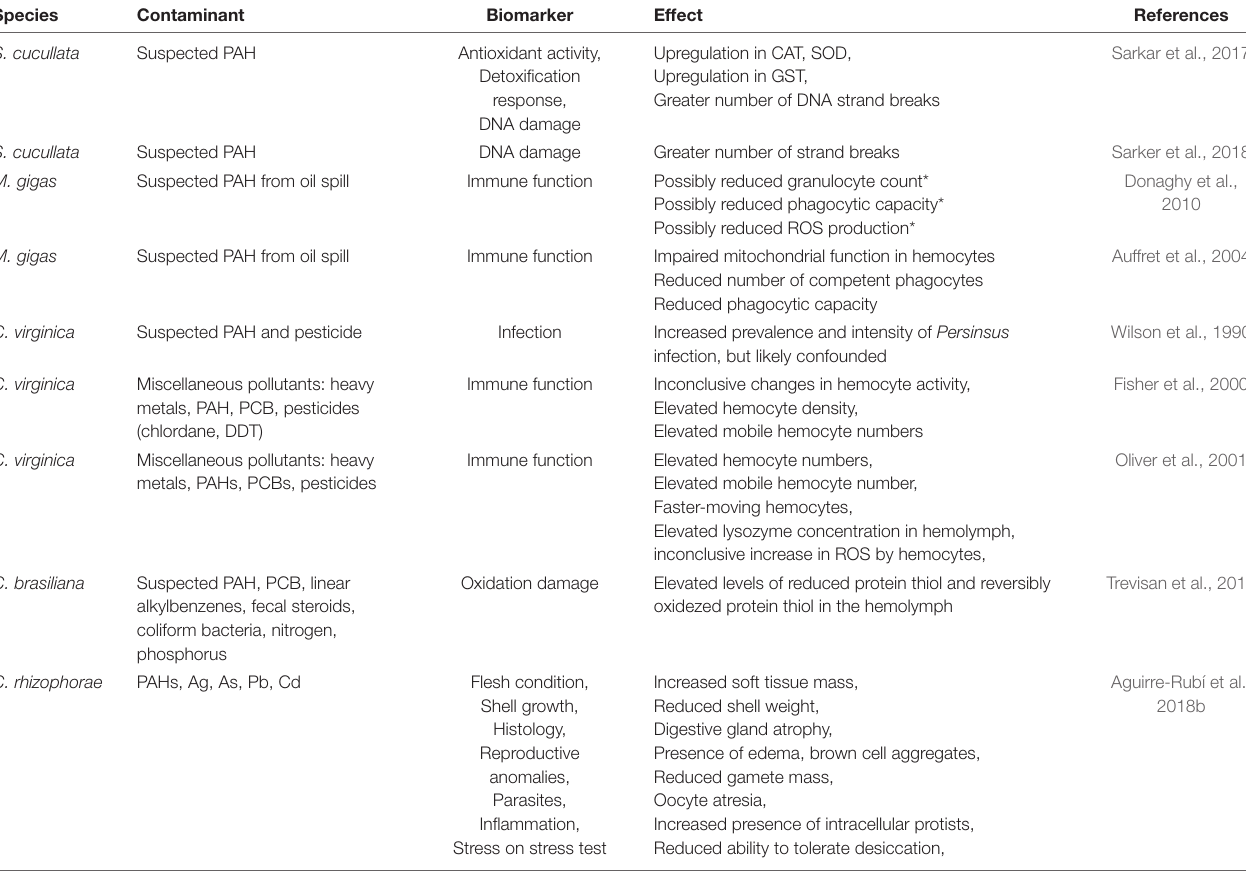
TABLE 3 | The summary of the observations of the field collections reflecting the toxicities of heavy metals and PAHs is organized here.